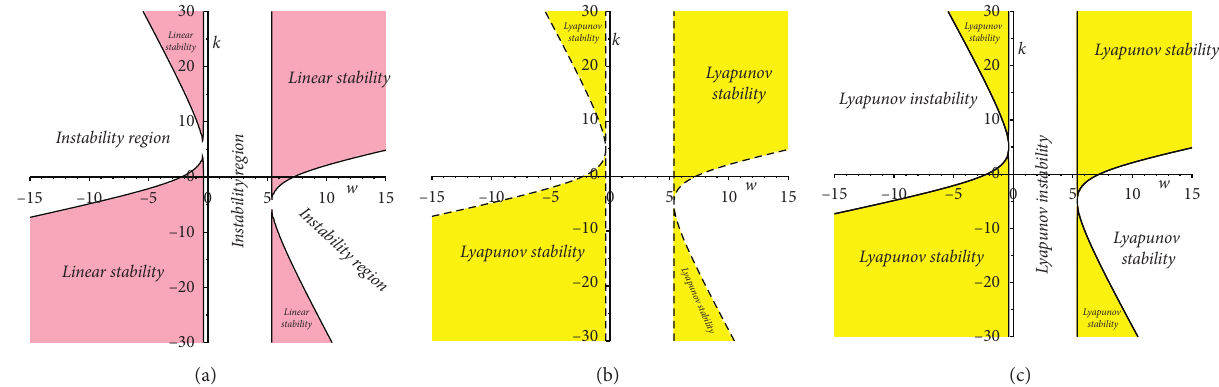
Figure 3: Regions of stability and instability for the permanent rotation E A � 3 , B � 4 , C � 5 , d � 5 , b � 10 , a � 15 , g � 9 . 8 , m � 1 , z 0 � 1.